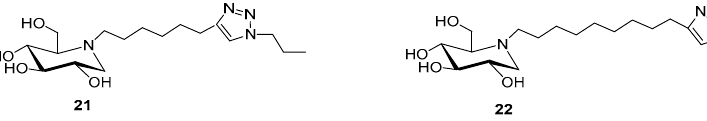
Figure 2.: Structure of monovalent inhibitors 21-22 . Figure 2. Structure of monovalent inhibitors 21 – 22 Table 1. Inhibition activity of (DNJ) 8 BU[4] 3-5 and (DNJ) 12 BU[6] 6-11 towards Jack Bean α -mannosidase.